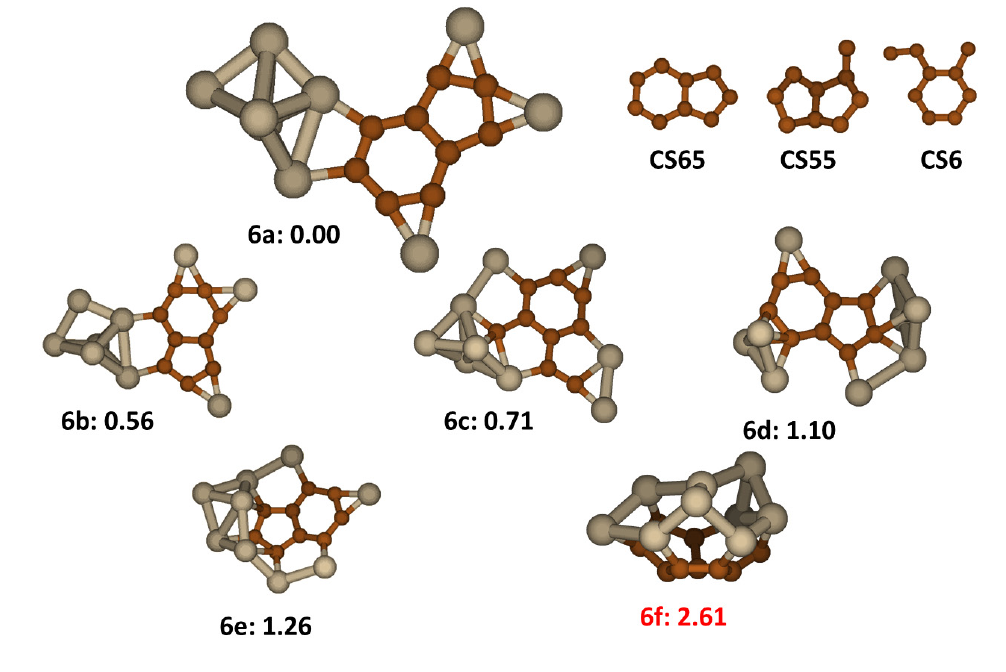
Figure 6. The structures and relative energies (in eV) of the lower energy Si and carbon segregations. Structure 6f is previously reported in ref.